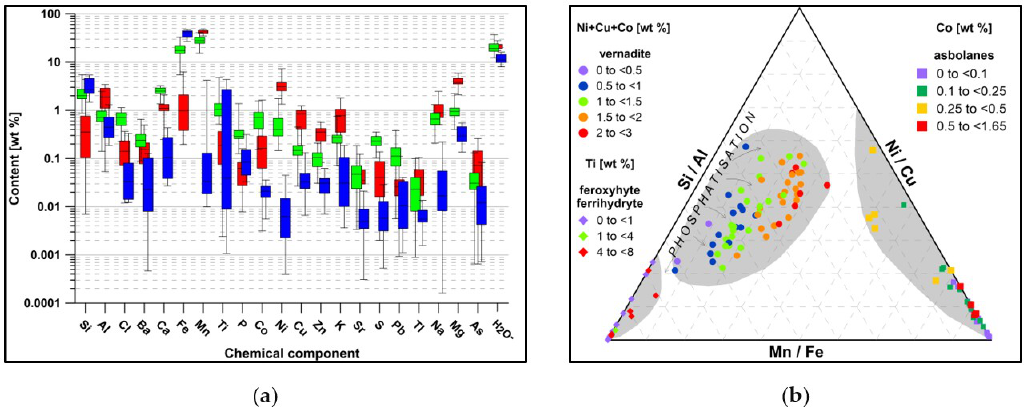
Figure 8. Chemical variability and classification of DHR Fe-Mn oxyhydroxides; ( a ) whisker plot shows chemical variability between elements in the identified Fe-Mn bearing phases; blue for feroxyhyte and ferrihydrite, red—asbolanes, green—vernadite; whiskers represent minimum and maximum values; black line in boxes is a mean value; H 2 O − calculated as rest from EPMA; ( b ) discrimination diagram of DHR crusts Fe-Mn bearing oxyhydroxides, according to Mn/Fe, Si/Al, Ni/Cu ratios and selected elements content (Ni + Cu + Co, Ti and Cu); gray areas represent fields of vernadite, asbolanes and feroxyhyte-ferrihydrite. Arrows indicate increase of phosphatization. All data from